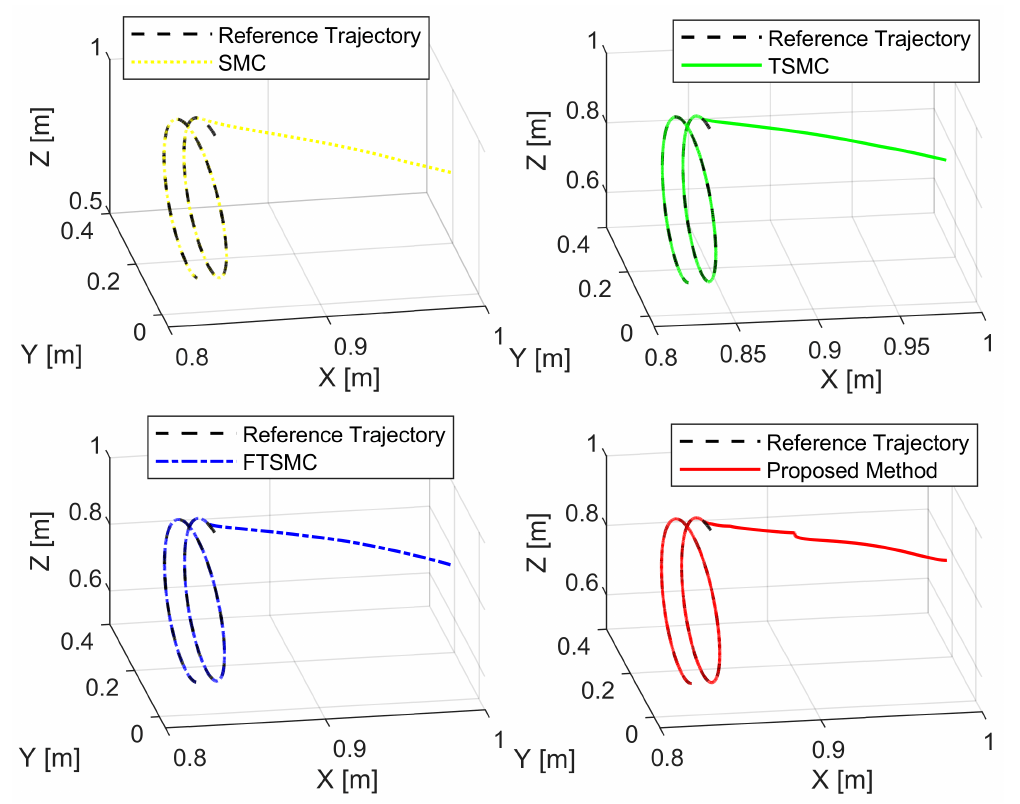
Figure 6. The real trajectory under each controller versus the desired trajectory.